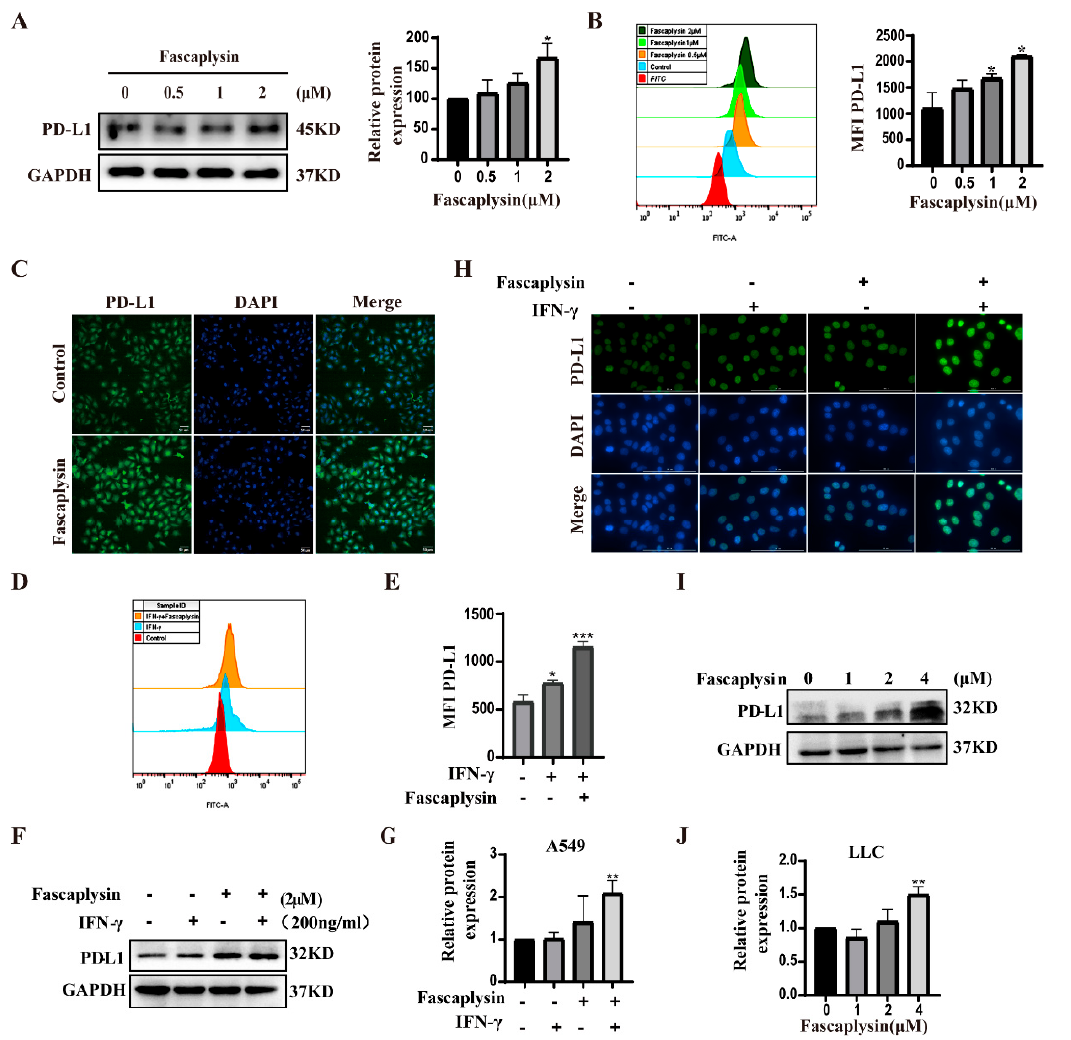
Figure 6. Fascaplysin promoted PD-L1 expression in NSCLC cells. ( A ) PD-L1 protein expression was detected by Western blotting. ( B ) After treatment of A549 cells with the PD-L1 kit, the fluorescence intensity of PD-L1 was analyzed by flow cytometry. The histogram is a quantification of the fluorescence intensity of PD-L1. ( C ) Immunofluorescence showing the level of PD-L1 protein in A549 cells. ( D , E ) A549 cells were treated with IFN- γ (200 ng/mL) and fascaplysin (2 µ M) for 3 h and PD-L1 fluorescence intensity was detected by flow cytometry using a PD-L1 kit. Histograms show quantitation of PD-L1 fluorescence intensity. ( F , G ) A549 cells were treated with fascaplysin and IFN- γ , alone or in combination, and PD-L1 expression was examined by Western blotting. ( H ) LLC cells treated with fascaplysin (4 µ M) and IFN- γ (200 ng/mL), alone or in combination, were examined for PD-L1 expression by immunofluorescence. ( I , J ) LLC cells were treated with fascaplysin (0, 1, 2, 4 µ M) at various concentrations for 3 h to detect PD-L1 expression by Western blotting. Analysis results represent mean ± SD, * p < 0.05, ** p < 0.01, *** p <